Question: Briefly state, in one sentence, what is plotted here.
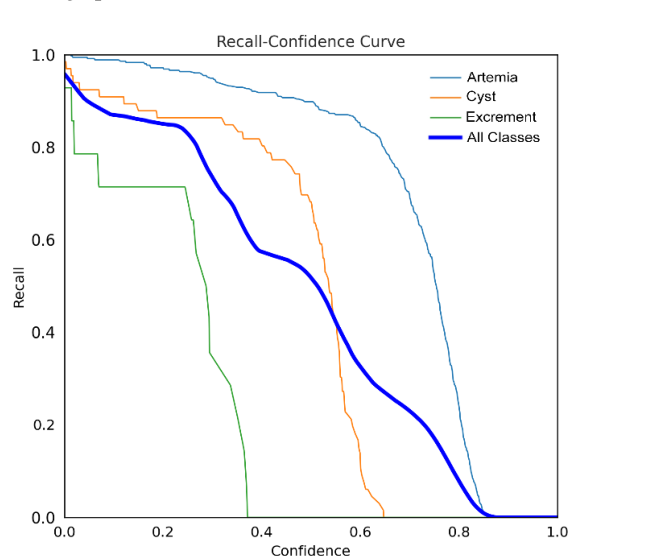
Answer: YOLOv5 Recall - confidence curve